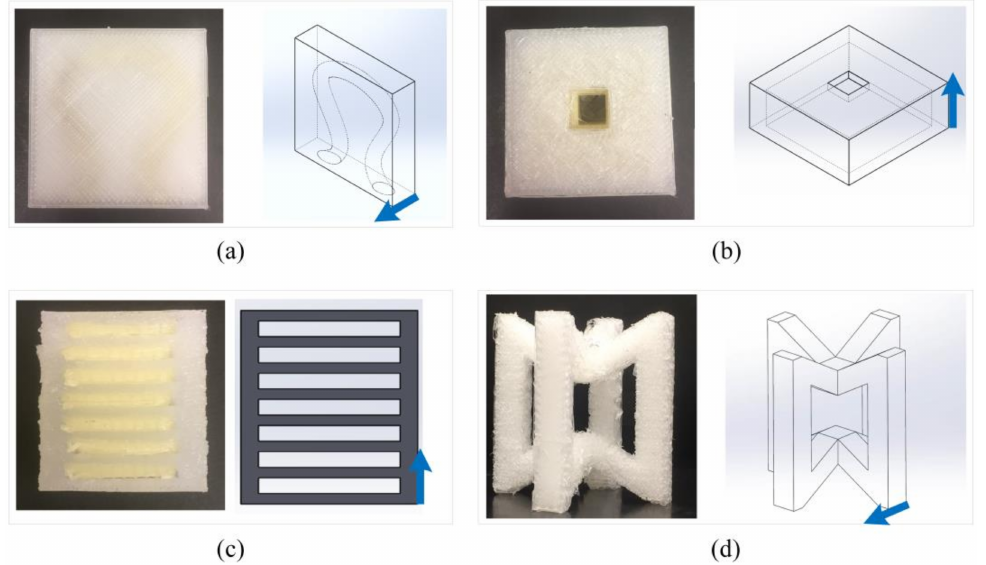
Figure 10. Examples of printed silicone parts with overhang structures. The arrows indicate the build direction (z) and the support structures were not removed in ( a – c ). ( a ) a box with internal channel, ( b ) a hollow box with an opening on top, ( c ) a multi-layer shelf, and ( d ) an auxetic